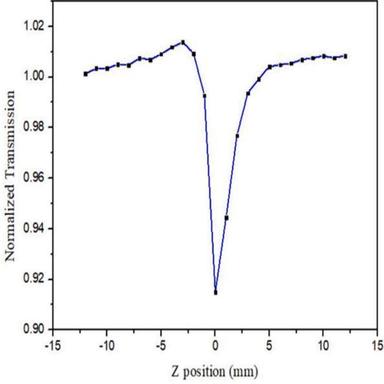
G4C3NBM crystal's open mode Z-scan configuration.